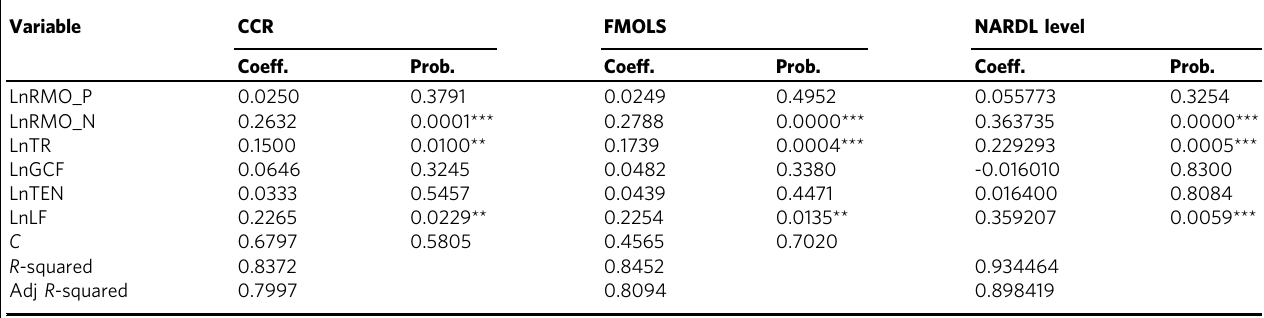
Table 8 Cointegrating regression